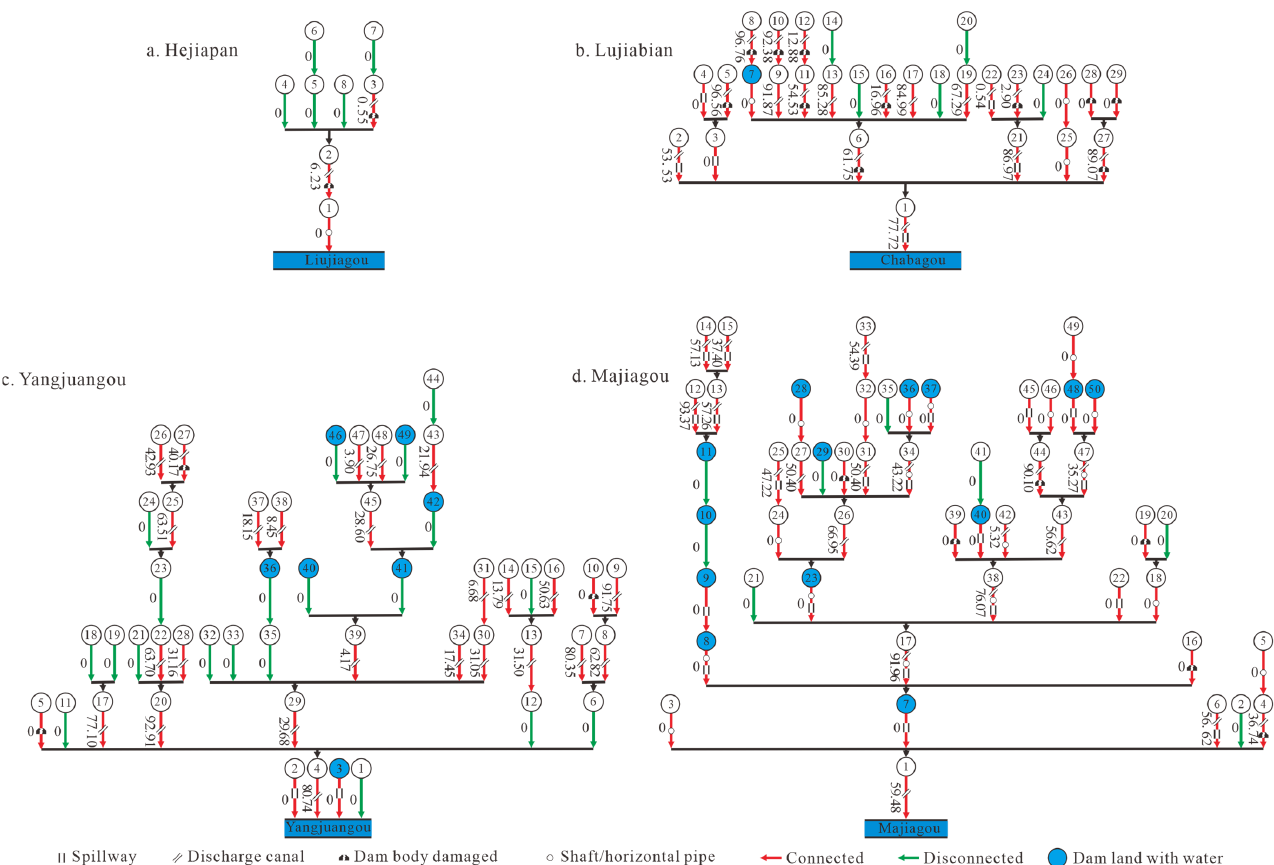
Figure 5. Position and connection modes of check dams in the four watersheds (the number is the SCCD of each check dam). According to the different cascade modes of each dam system, the dam system